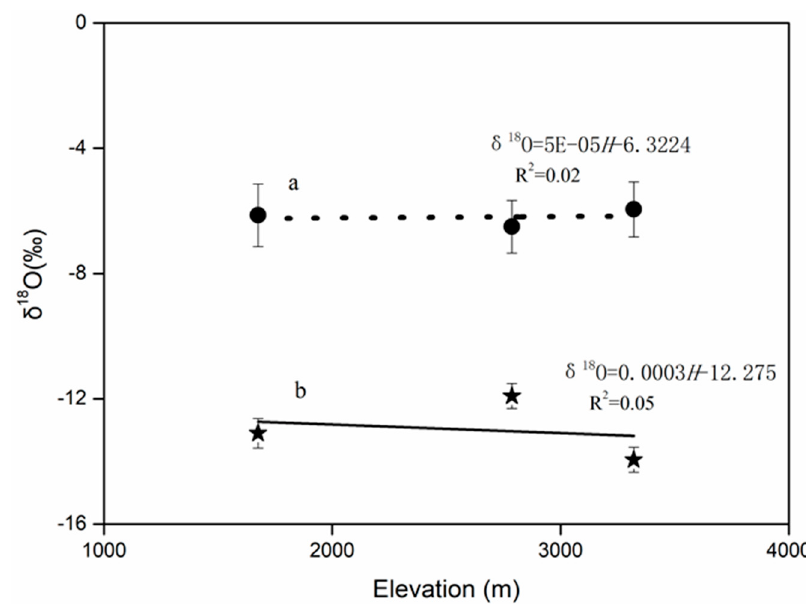
Figure 4. The δ 18 O variability with elevation in the warm and cold seasons from 2007.10 to 2008.9 in the upper reaches of the Heihe River Basin. Error bars represent relative standard deviation (RSD). a: